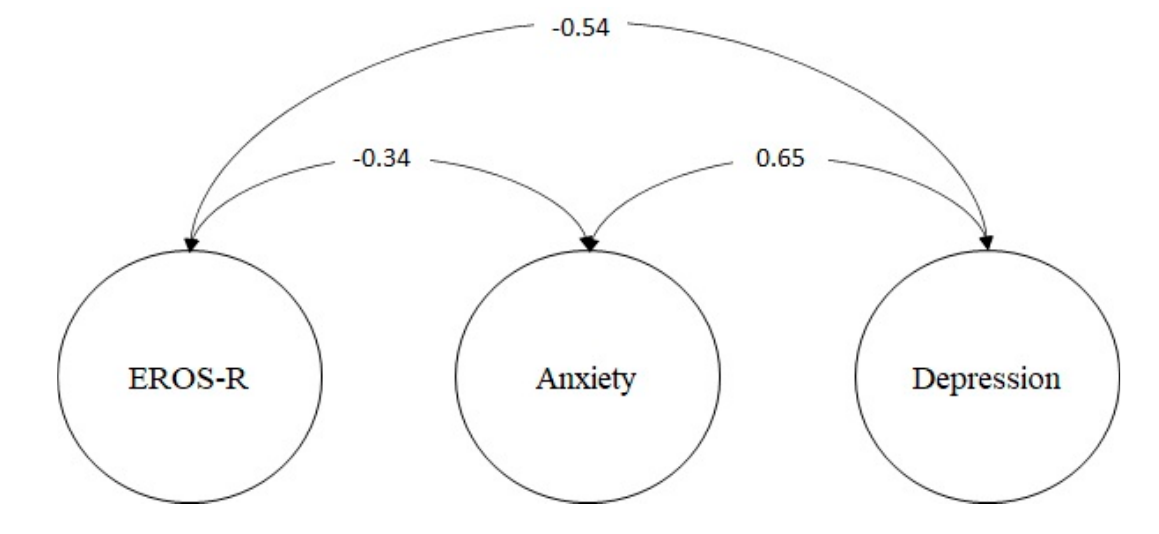
Figure 3. Relationship model with other constructs.